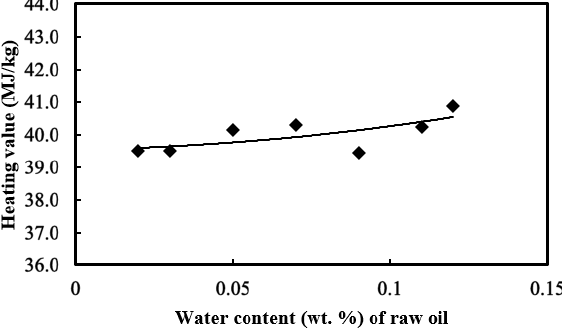
Figure 3. Effects of added water content in palm oil on the heating value of the biodiesel